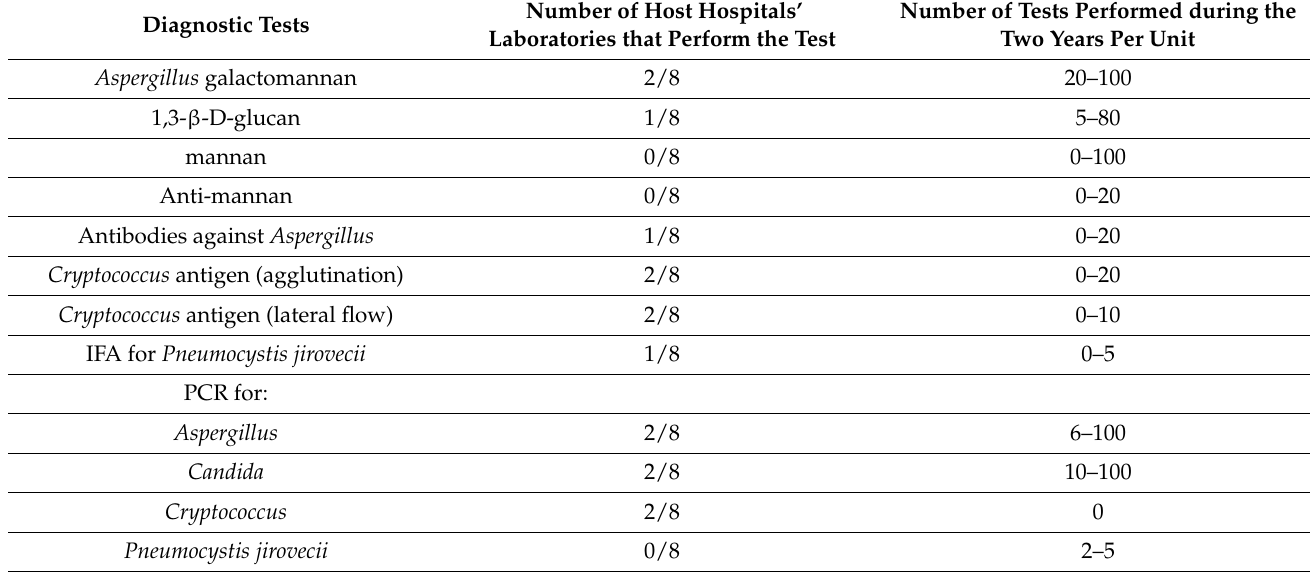
Table 4. Non-culture-based methods for the diagnosis of IFIs in the patients of the Greek paediatric haematology-oncology units: host hospital’s capacity and total number of tests performed during the years 2019 and